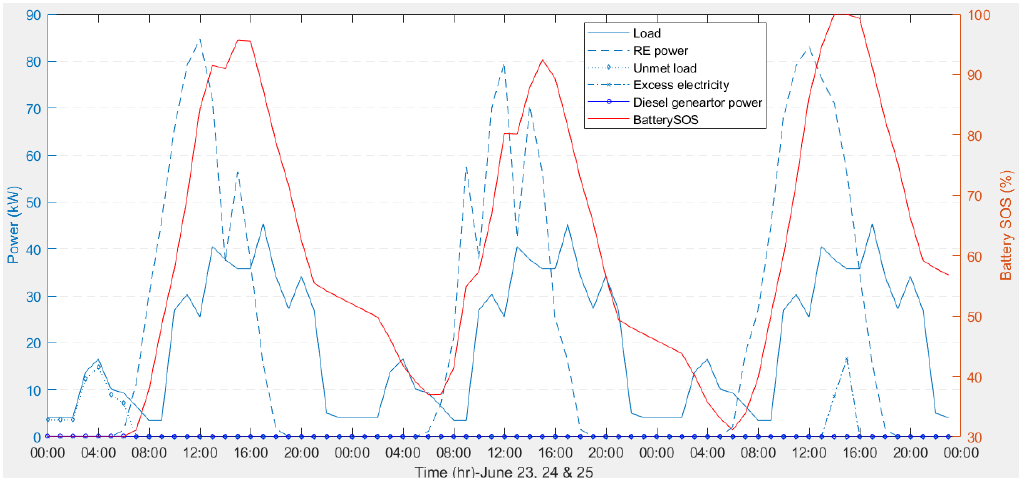
Figure 10. The hourly profile of the SOC of the battery bank during the simulation year.